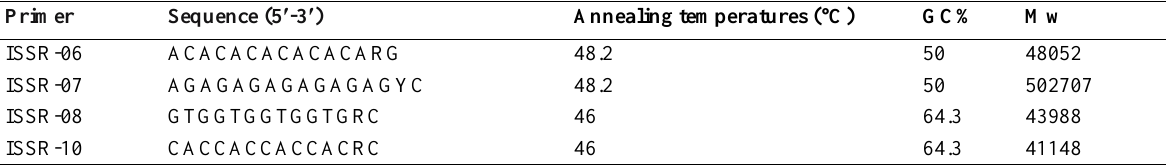
Table 2. Primers characteristics for ISSR analysis.